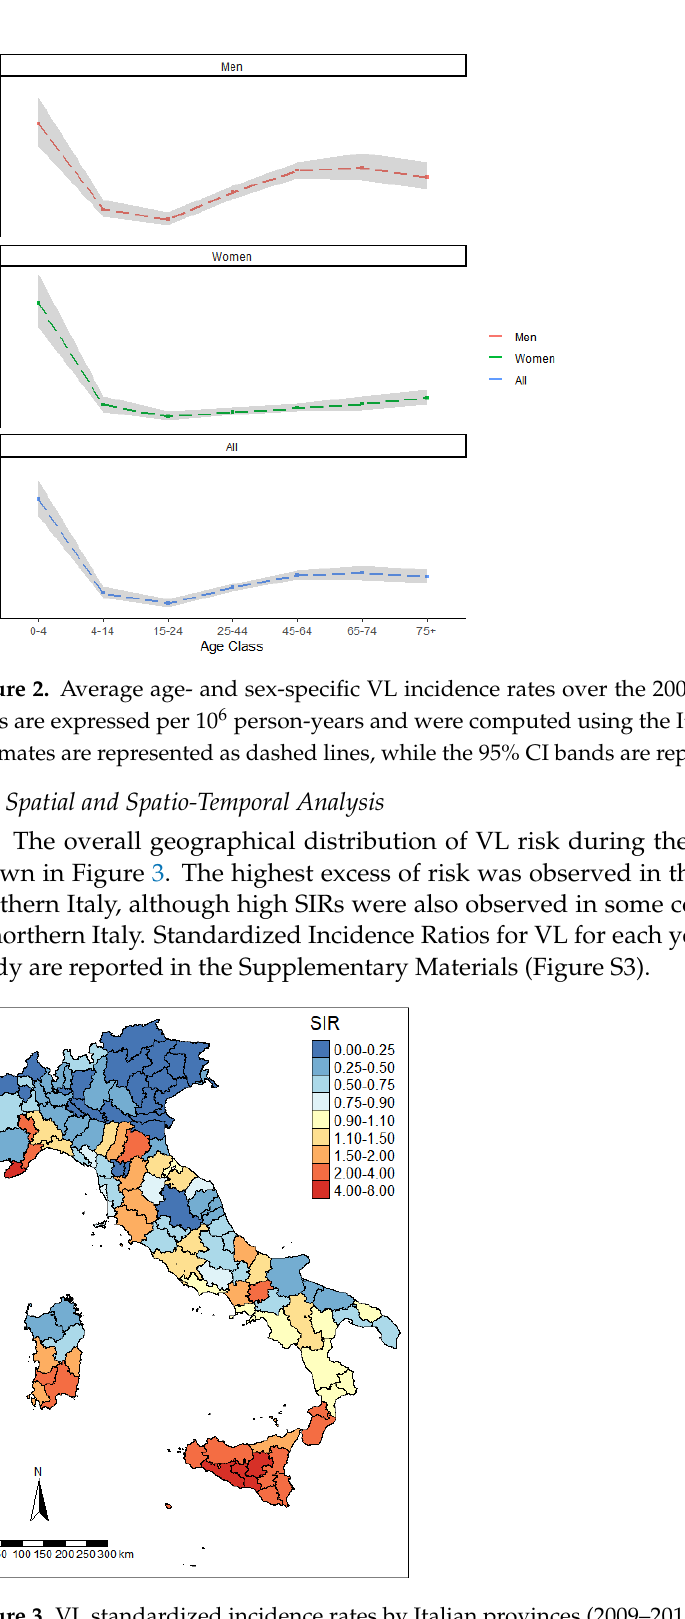
Figure 1. Year-specific VL standardized incidence rates between 2009 and 2016 . Age and sex stand- ardized IR are expressed per 10 6 person-years and were computed with direct standardization using the Italian census data of 2011 as reference population. Estimates are represented as dashed lines, while the 95% CI bands are represented as shaded areas.